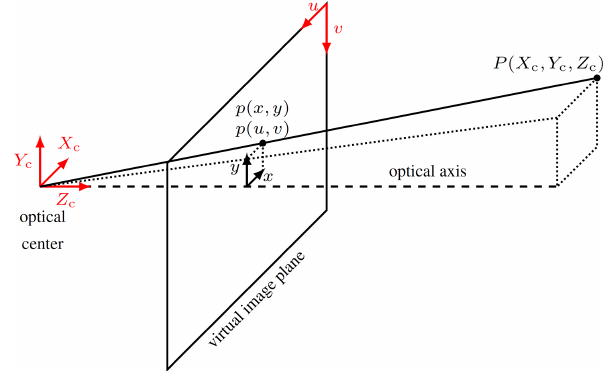
Figure 1. Relationship between a 3D point P ( X c ,Y c ,Z c ) and an image point p ( u,v ) in the pinhole camera model with a virtual im- age plane; based on Ordoñez Müller